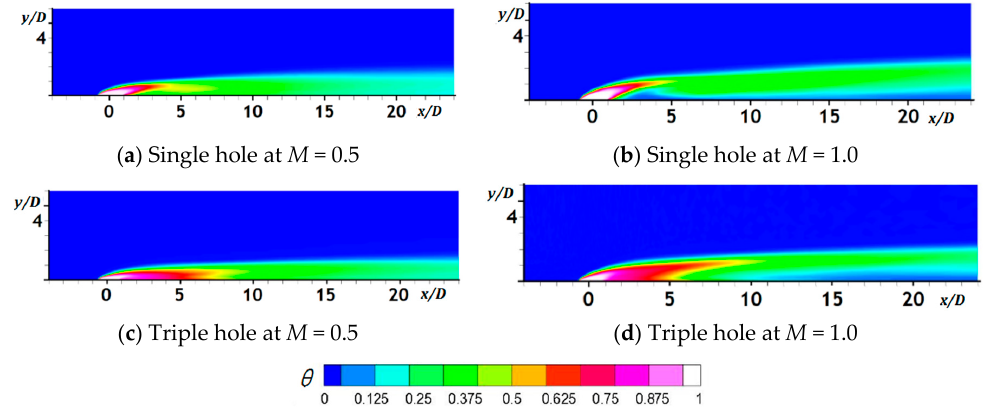
Figure 13. Central cross-sectional contours of the dimensionless mean temperatures in the z = 0 plane.